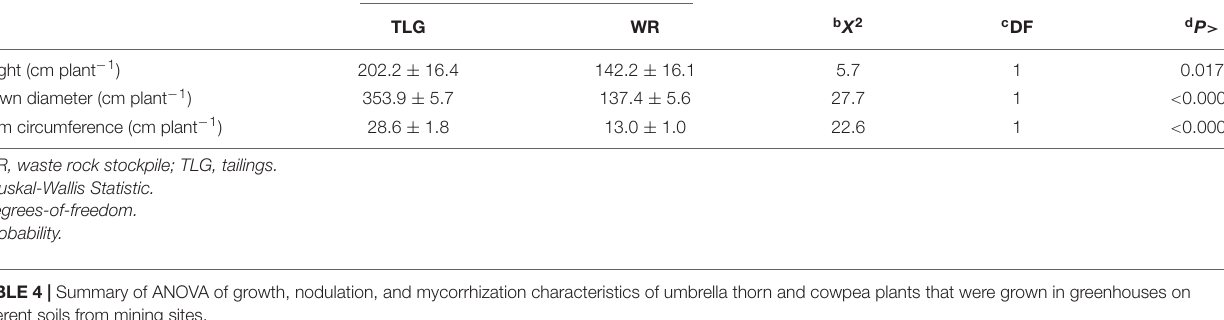
TABLE 3 | Summary of analyses of the variance (ANOVA) and means on height, crown diameter, and stem circumference of umbrella thorn 3 years after planting at mine waste sites. Growth trait